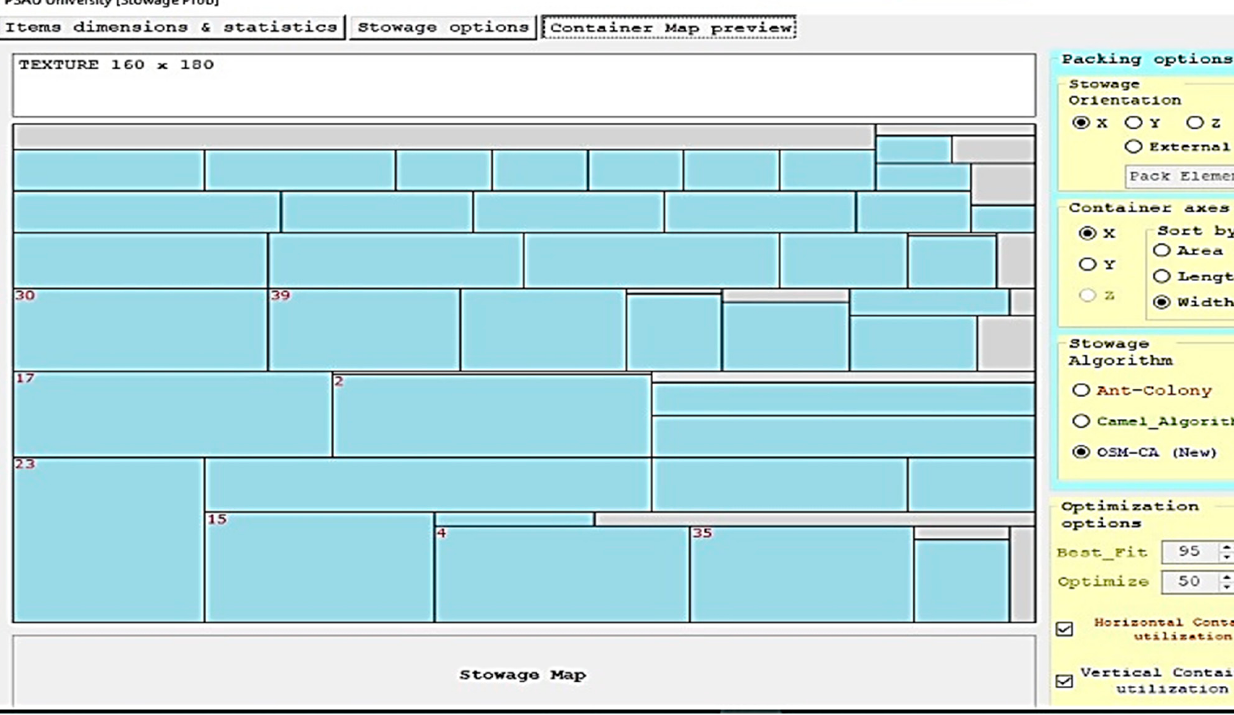
Figure A9. The stowage map by proposed algorithm optimization OSM-CA.